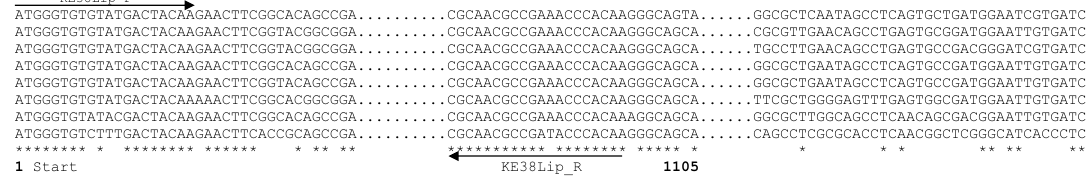
Figure 1. Multiple alignments of 8 different Pseudomonas fluorescens lipase genes. Only 5 ′ , 3 ′ , and middle sections of the lipase genes are shown. Binding sites for the degenerate primers are designated by arrows. Numbers on the left refer to lipase genes from P. fluorescens strains involved in the alignment. 1. Pseudomonas sp. 7323 lipase gene, 2. P. fluorescens lipase (lipB41) gene, 3. P. fluorescens lipase (lipB52) gene, 4. Pseudomonas sp. MIS38 lipase gene, 5. P. fluorescens lipase (lipB) gene, 6. P. fluorescens lipA lipase gene, 7. P. fluorescens strain 26-2 lipase gene, 8. Pseudomonas sp. JZ-2003 lipase gene. Numbers in bold indicate the nucleotide positions on the lipase genes. The sequences were obtained from NCBI (http://www.ncbi.nlm.nih.gov/) and aligned by the Clustal Omega software (www.clust al.org). The accession numbers of the related lipase sequences are given in Table